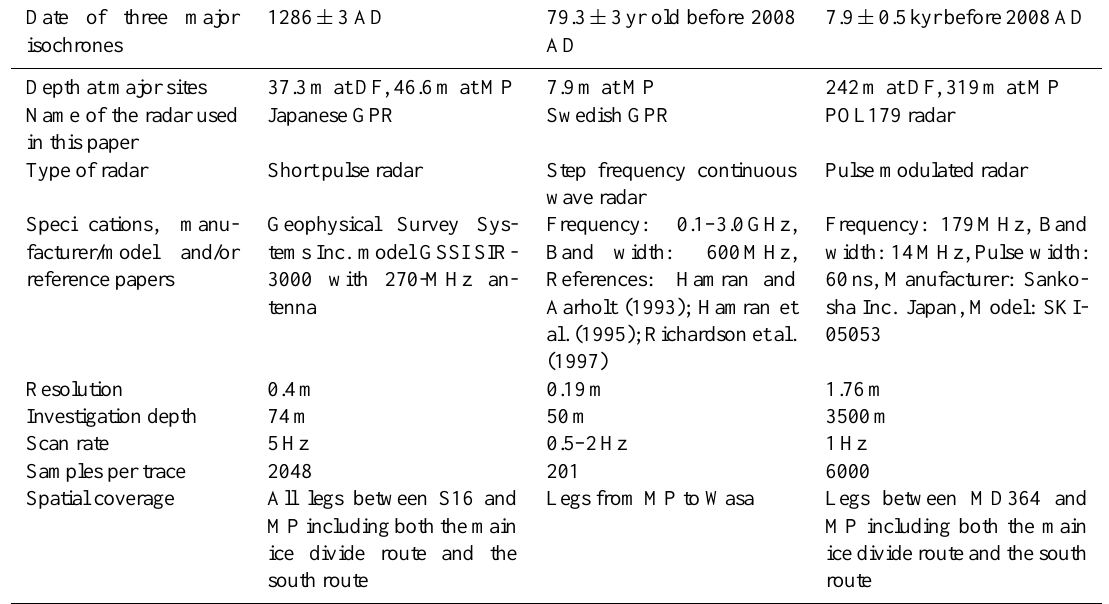
Table 2. A summary of the three major isochrones used in this study and the three types of